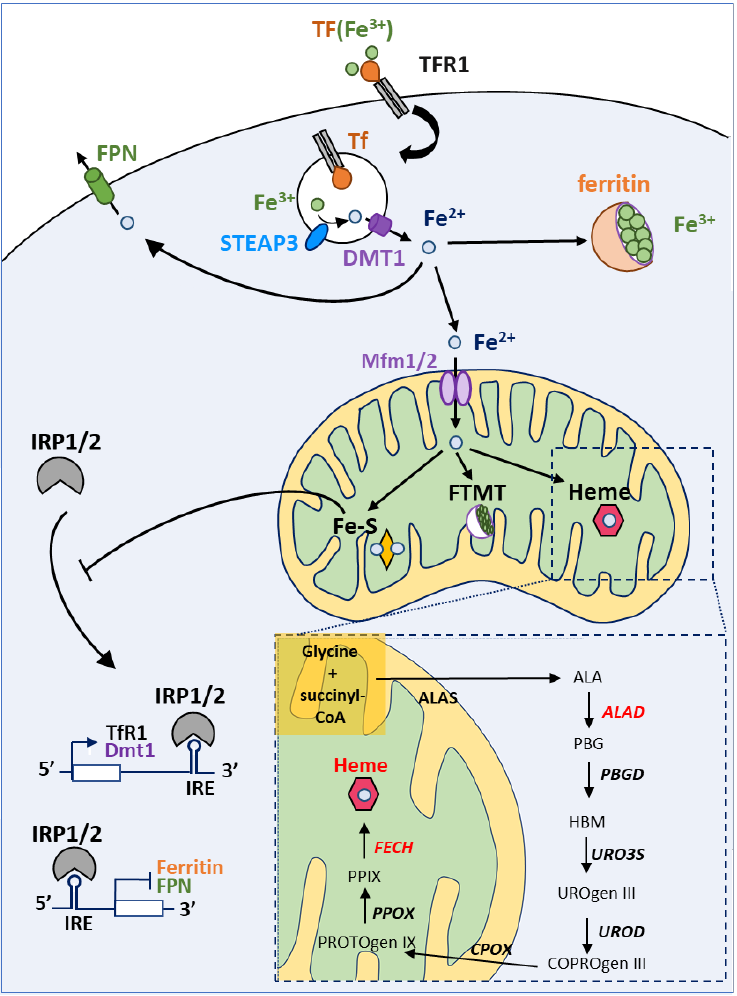
Figure 4. Iron homeostasis and utilization at the cell level. Iron cellular uptake is controlled by transferrin and its receptor (TF and TFR1, respectively). Afterwards, in the endosome, iron is reduced thanks to the action of STEAP3 (which converts the insoluble Fe 3+ to soluble Fe 2+ ) and released from the endosome into the cytoplasm by the DMT1 channel. Free iron can be stored by ferritin in the cytoplasm or can be transported into the mitochondria, thanks to Mitoferrin 1 and 2 transporters (Mfrn1/2). Excess of iron is released out of the cell by Ferroportin (FPN). Inside the mitochondrion, iron can be stored in FTMT (mitochondrial ferritin) or incorporated in heme or Fe-S clusters. IRP1 and 2 (Iron Related Protein 1 and 2) are the major regulators of iron metabolism. In iron-depleted cells, IRP1 can bind IRE (Iron Response Elements) motifs to promote or repress mRNA translation. If IREs are located in the 5 (cid:48) UTR, IRP1 binding represses mRNA translation under low iron levels. On the contrary, transcripts with IREs at the 3 (cid:48) UTR are stabilized and translated upon IRP binding. Hence, low iron levels lead to decreased Ferritin and FPN levels, but promote TFR1 and DMT1 synthesis. High levels of iron prevent IRP1 binding to IREs (see the main text for